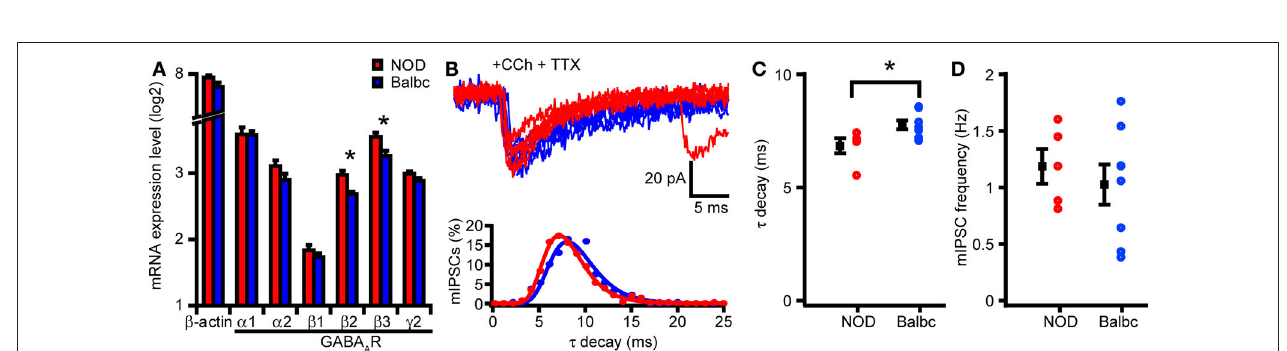
FiGuRe 5 | iPSCs in CA1 pyramidal cells of NOD and Balb mice differ in τ decay times. (A) Hippocampal slice (top) placed on a 64 electrode grid and example traces of local field potential and corresponding IPSCs in a CA1 pyramidal cell from an NOD mouse. Histogram (bottom) of decay time constants of IPSCs from NOD and Balbc mice. Histograms are fitted with lognormal functions. (B) Decay time constants of NOD ( n = 11) and Balbc ( n = 7)